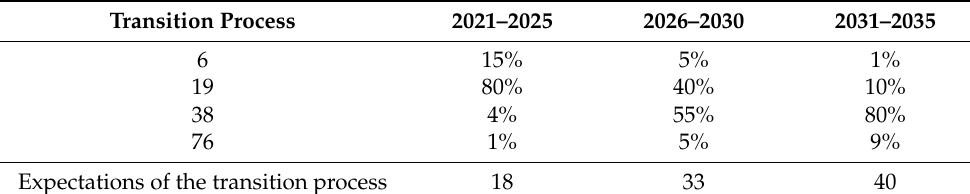
Table 2. The prediction probability of phased equipment investment of Qingdao